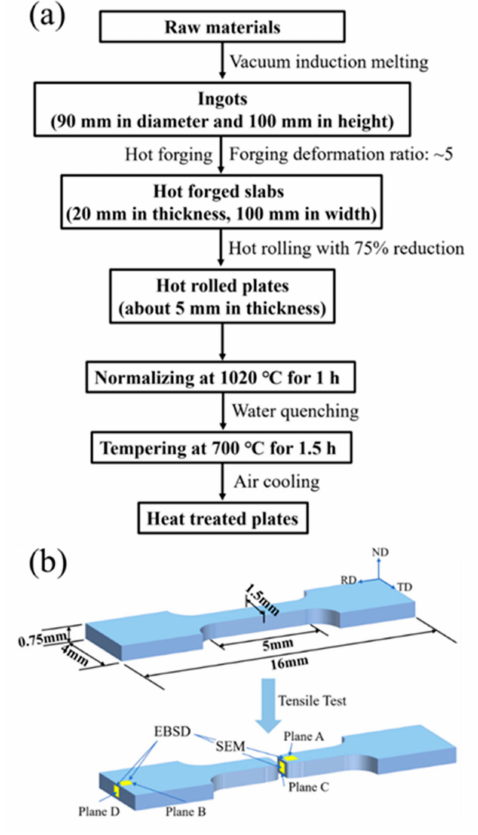
Figure 1. A schematic diagram of ( a ) manufacturing and heat treatment process and ( b ) microstruc- ture characterization